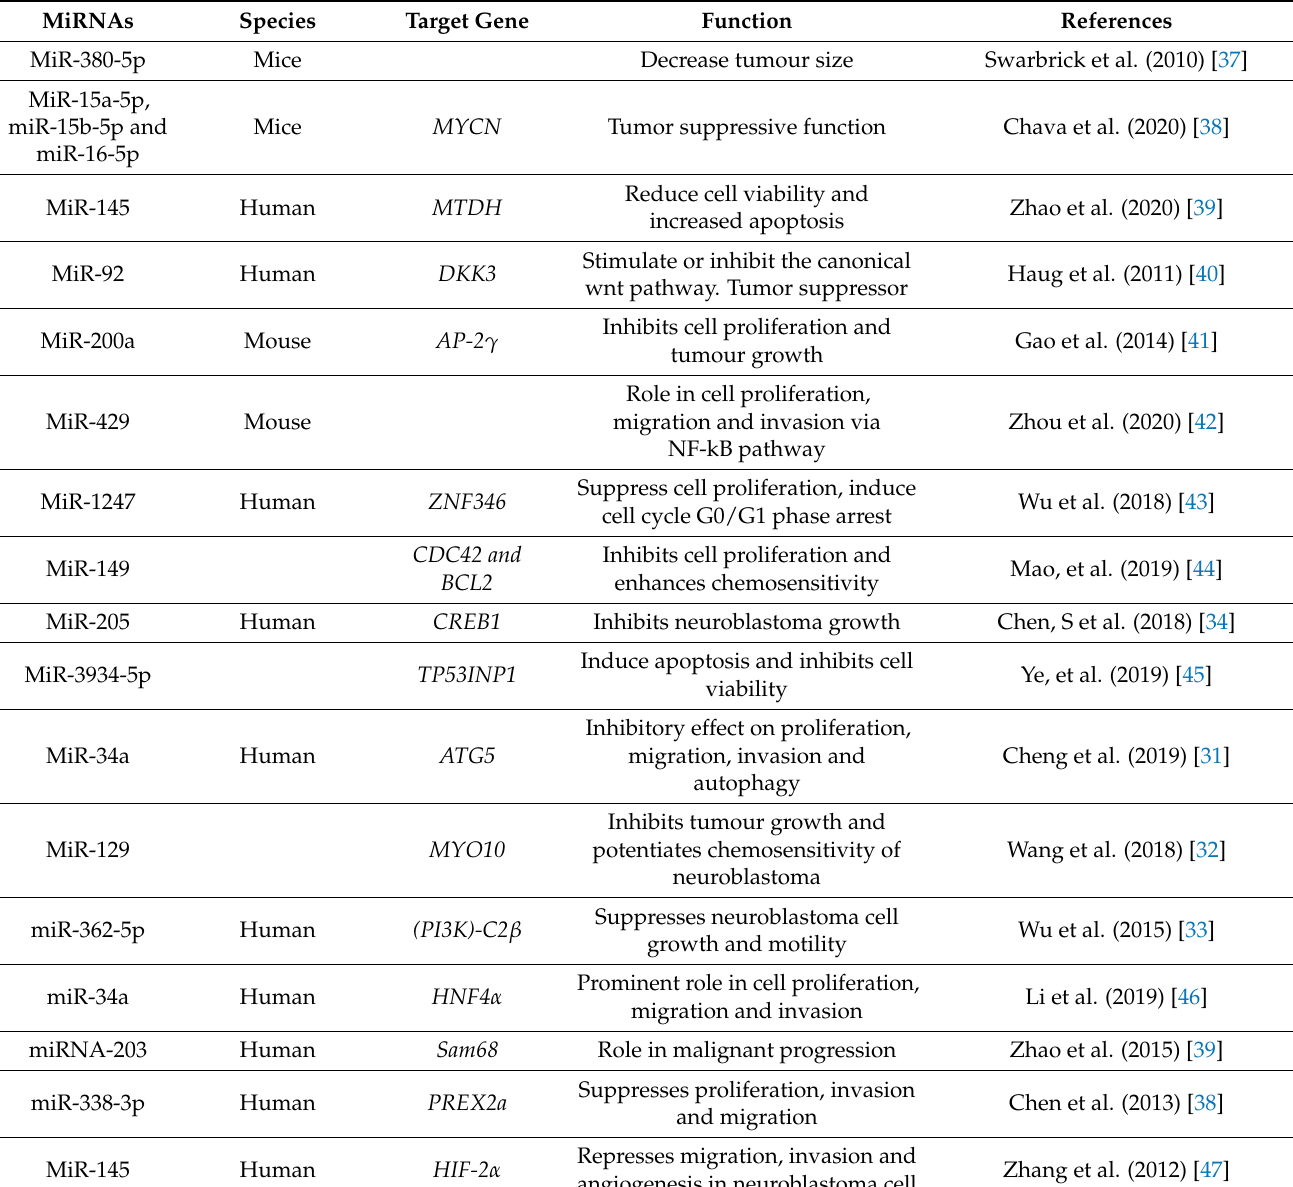
Table 1. The miRNAs and their function in